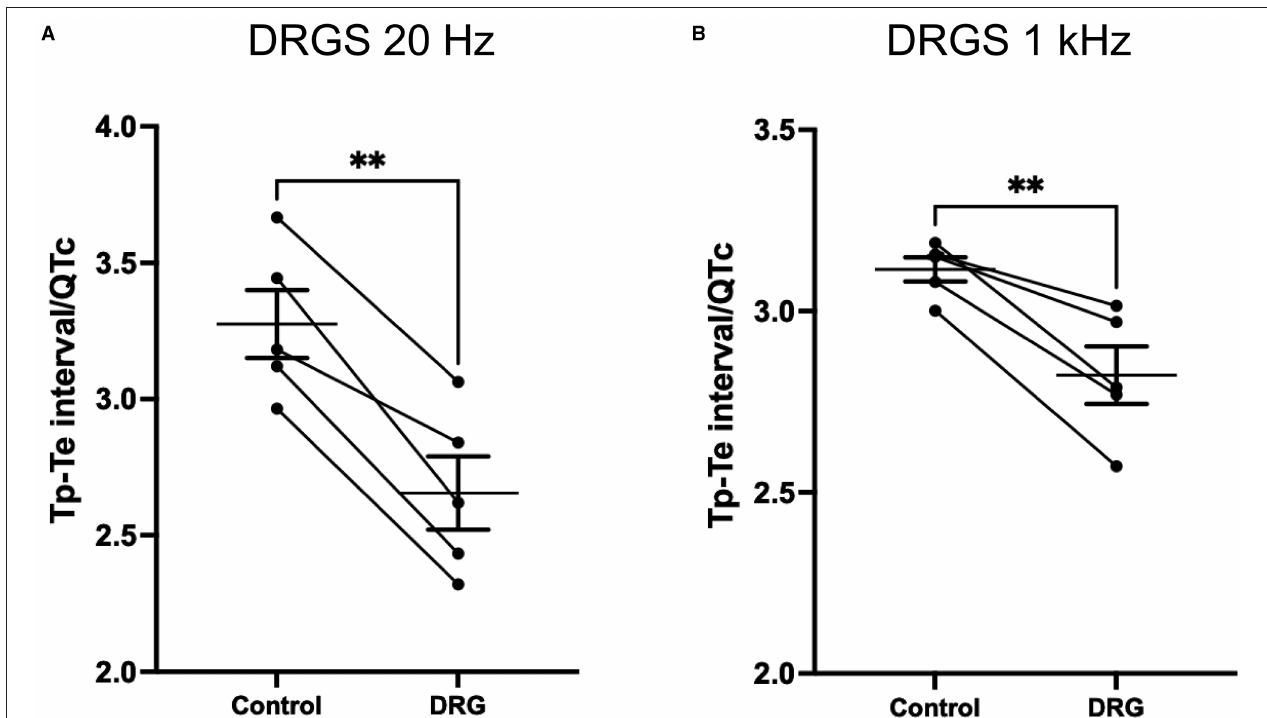
FIGURE 6 | DRG stimulation at both 20Hz (A) and 1kHz (B) decreased Tp-Te nterval/QTc which indicate that DRG stimulation had effect on reducing arrhythmogenesis substrate induced by S1/S2 pacing. Tp-Te measurement was performed at 1min post S1S2 pacing before and after DRG stimulation. (A) ** P = 0.014, (B) ** P = 0.007. Data are reported as mean ± standard error